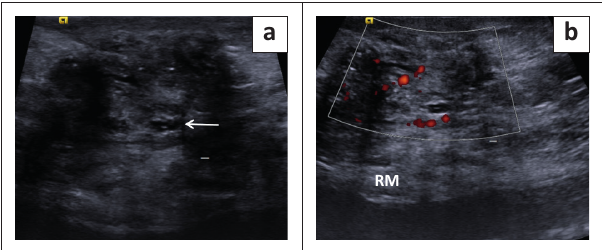
FIGURE 4: (a, b) Ultrasound image (a) in 32-year-old female with prior LSCS and hysterotomy with current complaints of cyclical scar site pain reveals an irregular hypoechoic lesion within the subcutaneous plane of the lower anterior abdominal wall showing multiple anechoic areas (arrow, a) and edge shadowing. Moderate intralesional flow was seen on Doppler (b) (rectus muscle [RM]).